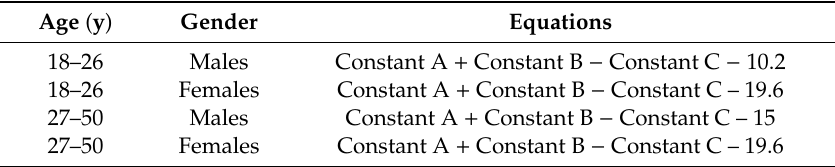
Table 2. Age and gender-specific equations to predict body fat